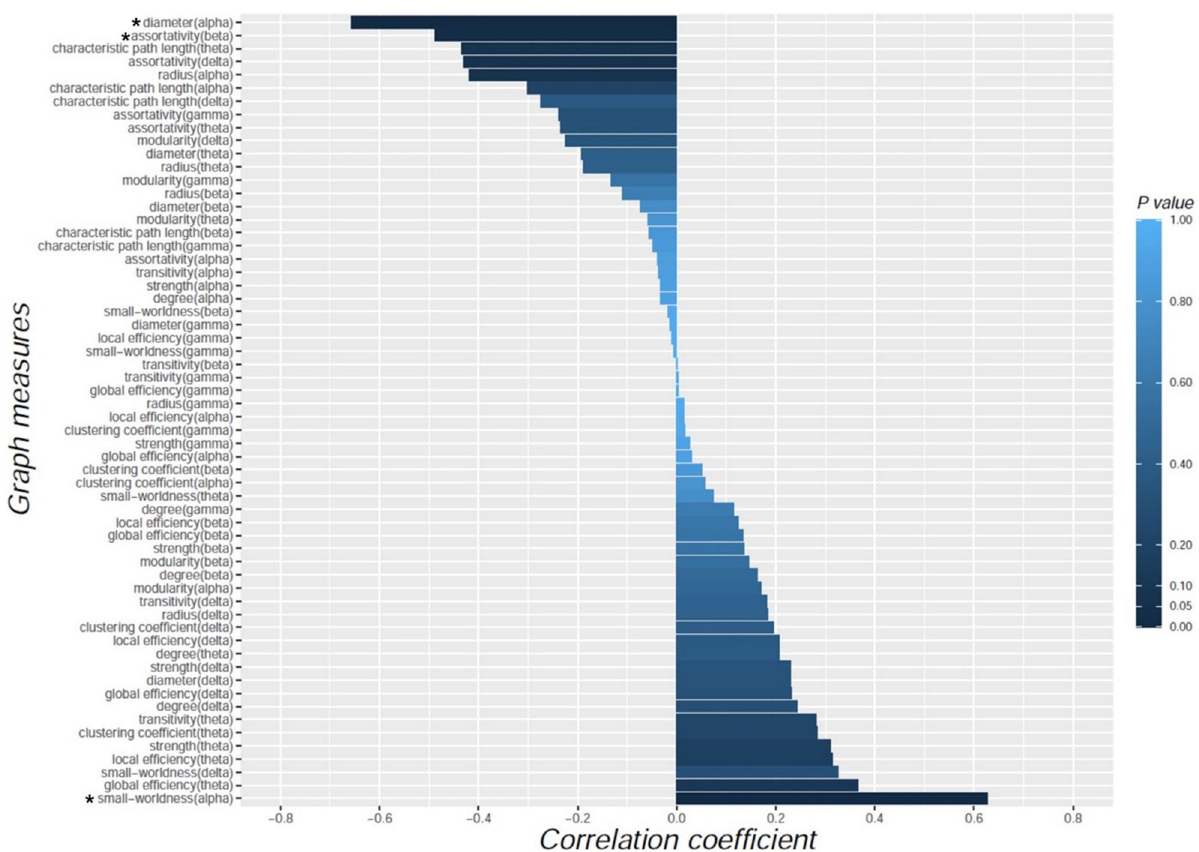
Figure 6. Correlations between the changes in global graph measures and the degree of improved performance on Trail Making Test Part B after coffee consumption. The horizontal bars represent the values of correlation coefficient. The color bar represents statistical significance (P value). Asterisks (*) represent statistical significance (P <